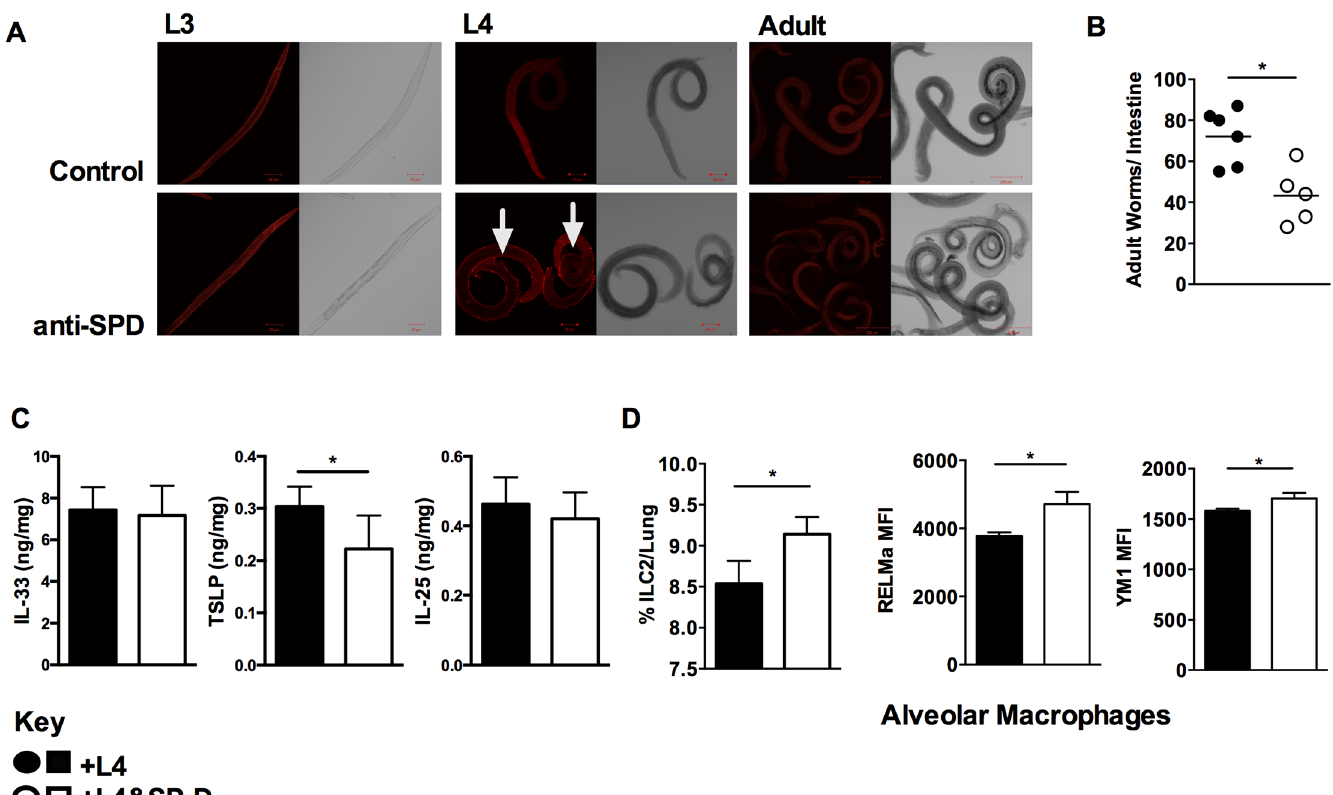
Fig 3. Selective SP-D binding to L4 Nippostrongylus brasiliensis enhances host protective immunity. Confocal microscopic images of L3, L4 and Adult stage of N . brasiliensis incubated with 20 μ g/ml of rfhSP-D, biotin-conjugated anti-rfhSP-D, followed by streptavidin-cy3 (a) . 250 L4 stage larvae, coated or uncoated with rfhSP-D were intra-nasally administered into na ï ve mice. Intestinal worm burden (b) , detection by ELISA of IL-33, TSLP and IL-25 in the lung (c) , percentage of lung ILC2 and mean fluorescence intensity (MFI) of markers of alternative macrophage activation were quantified at day 5 PI. (d) . Data are representative of 4 individual experiments. N = 5 – 8 mice per group. * P < 0.05, ** P <